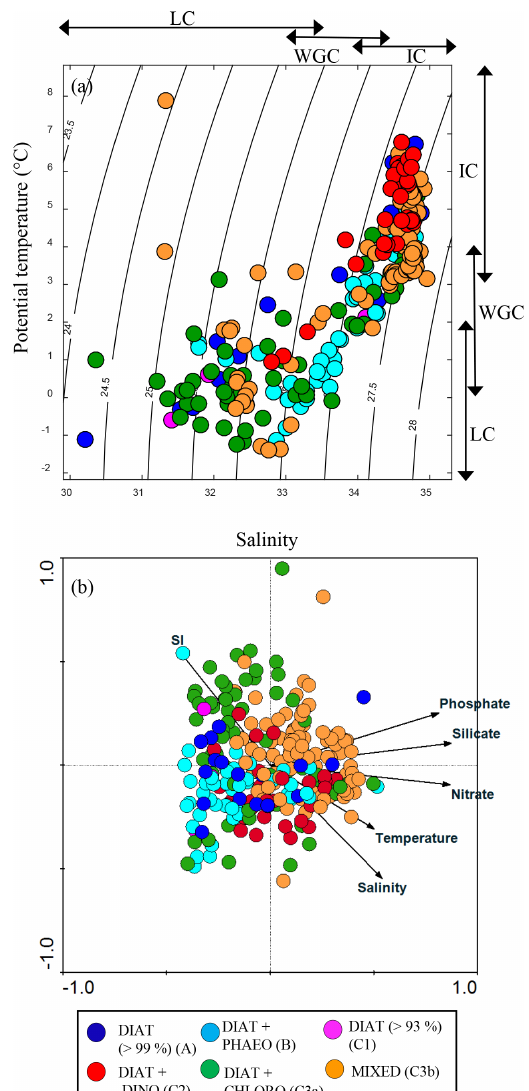
Figure 5. Positions of individual stations in relation to tempera- ture ( ◦ C) and salinity (a) and redundancy analysis (RDA) ordina- tion plot (b) . The stations are colour-coded according to the cluster groups (see details in Fig. 4). The TS plot (a) shows the approximate ranges of potential temperature ( ◦ C) and salinity of the Labrador Current (LC), the West Greenland Current (WGC) and the Irminger Current (IC). Arrows in (b) show the explanatory (environmental) variables used in the